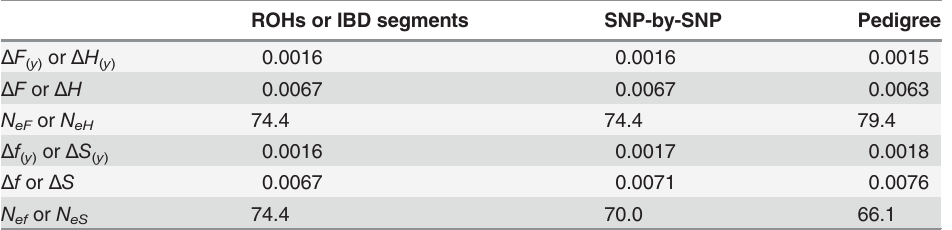
Table 3. Rates of change in inbreeding, molecular homozygosity, coancestry and molecular similarity per year ( Δ F (y) , Δ H (y) , Δ f (y) and Δ S (y) ), respectively, and per generation ( Δ F , Δ H , Δ f and Δ S ) using differ- ent sources of information, and estimates of effective population sizes obtained from Δ F ( N eF ), Δ H ( N eH ), Δ f ( N ef ) and from Δ S ( N eS ). ROHs or IBD segments SNP-by-SNP